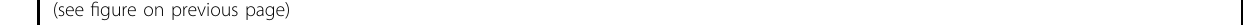
Fig. 4 Increased expression of paracrine factors related to hair regeneration and growth in amniotic fl uid – derived mesenchymal stem cells overexpressing Nanog (AF-N-MSCs). a Schematic describing the identi fi cation of the main paracrine factors from AF-N-MSCs. b Comparison of cytokine expression between AF-MSCs and AF-N-MSCs. c Relative mRNA expression levels of hair growth – related markers (bFGF, IGF, Wnt7a, PDGF- AA) in AF- and AF-N-MSCs. d Protein expression of the paracrine factors related to hair growth in AF- and AF-N-MSCs, as determined by western blot. e Cytokines related to hair growth secreted from AF- and AF-N-MSCs. Cytokine concentration was measured by enzyme-linked immunosorbent assays. f Paracrine effect of AF-N-MSC – derived conditioned media (AF-N-CM) on the growth of hair follicle dermal papilla cells. Minoxidil (1 µM) served as a positive control. Data are represented as the mean ± SD ( n = 3). * p < 0.05; ** p < 0.01; *** p <